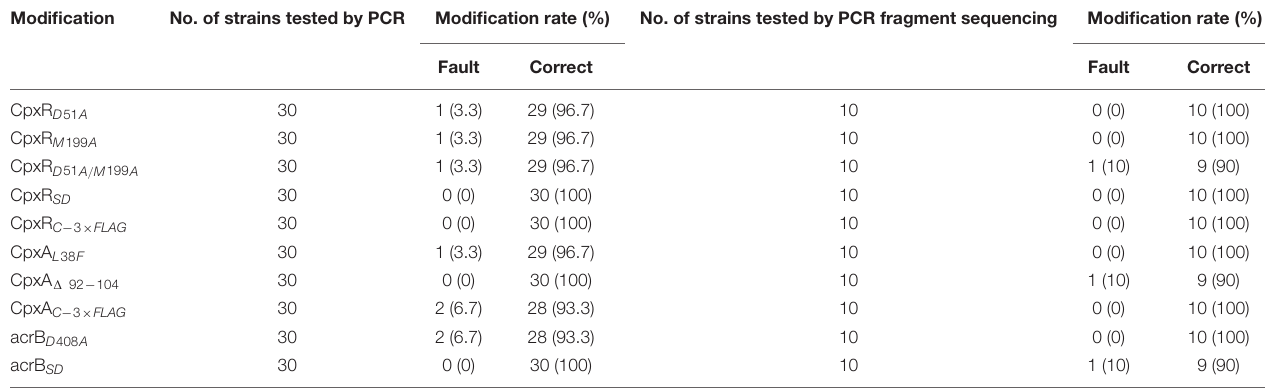
TABLE 2 | Efficiency of gene modification by the proposed method. Modification